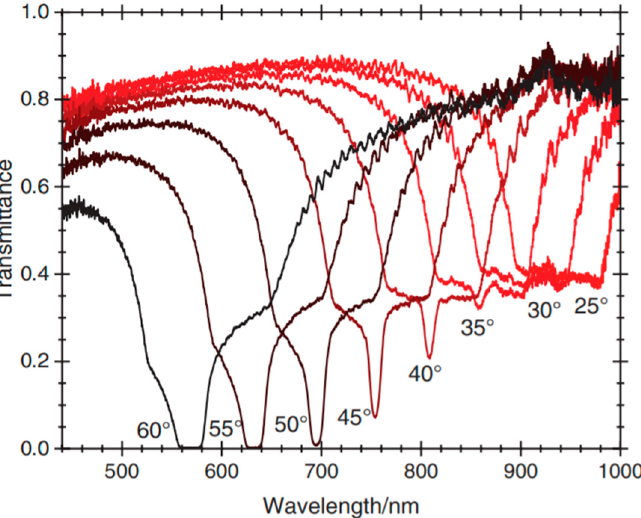
Figure 13. Transmission spectra (unpolarized white light probe) collected from sample CLC with a thickness of 30 µm as a function of incidence angle. The initial notch position of the sample is 1080 nm. Adapted from ref. [91].